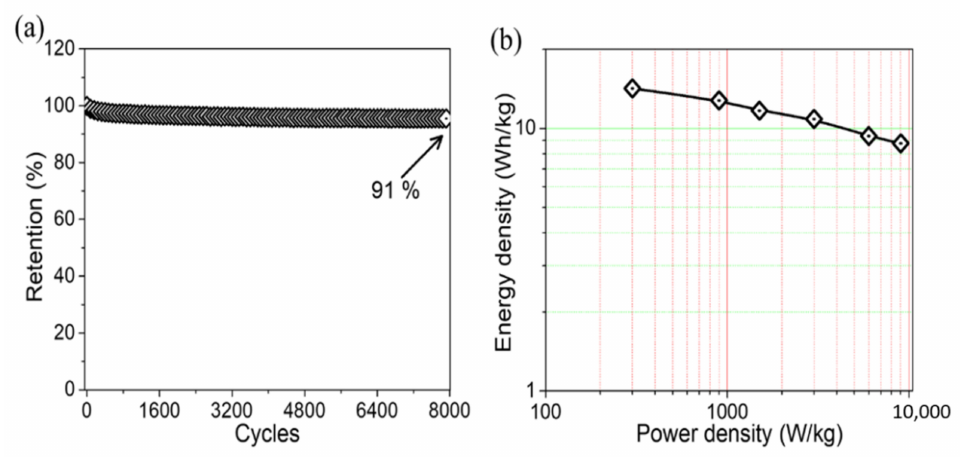
Figure 6. ( a ) Cycling performance of the TiO 2 /PVDF electrode; ( b ) Energy density versus power density.